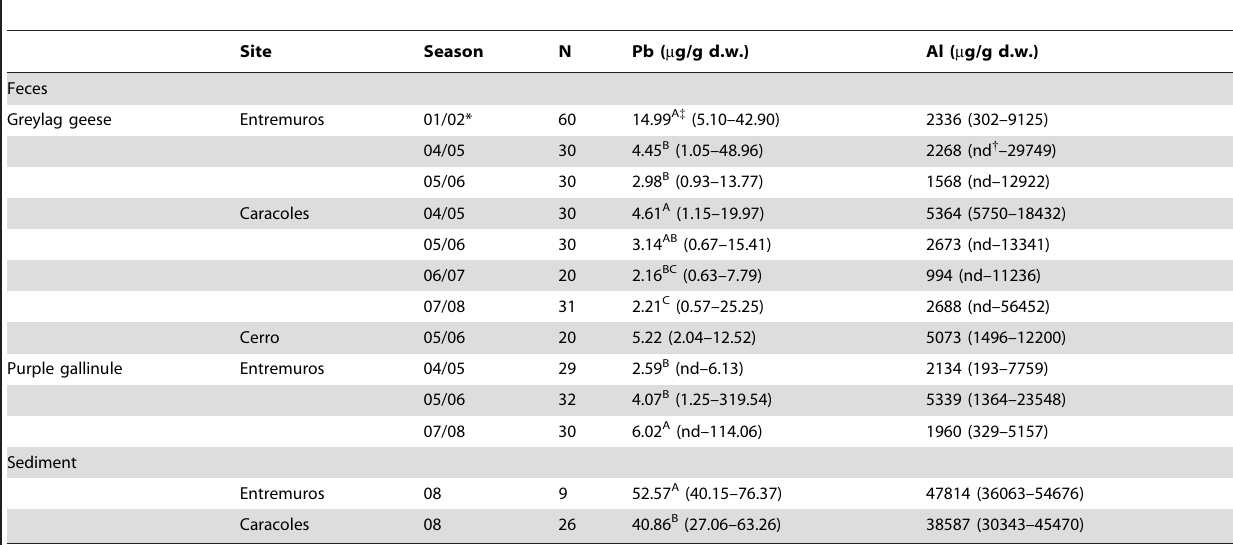
Table 1. Geometric mean (range) of Pb and Al concentrations (in m g/g dry weight) in greylag geese and purple gallinule feces, and samples of sediment collected at different study sites in Don˜ana during the 2004 to 2008 winters.